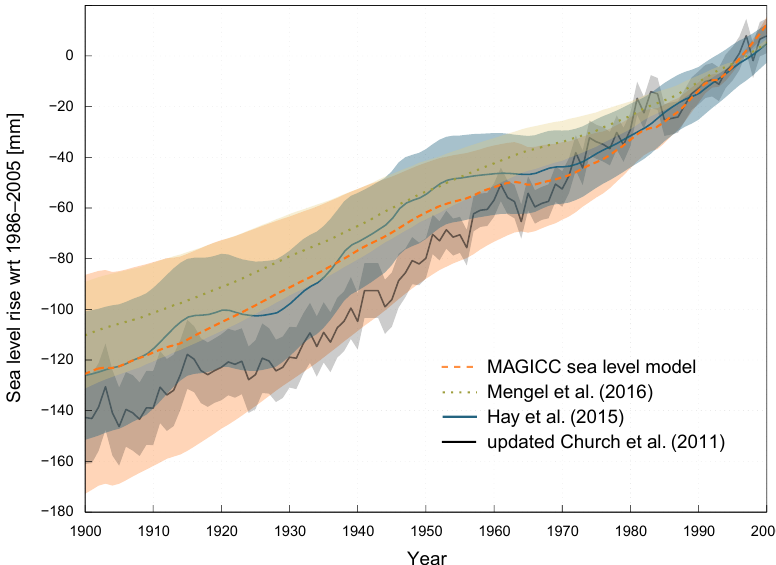
Figure A3. Historical modeled and observed SLR from 1900 to 2000, relative to the 1986–2005 mean. Median and 90% uncertainty ranges are shown for the MAGICC hindcast (orange) and results from Mengel et al. (2016) (khaki), with observed sea level time series and respective uncertainties based on Hay et al. (2015) (blue) and the updated Church et al. (2011) datasets